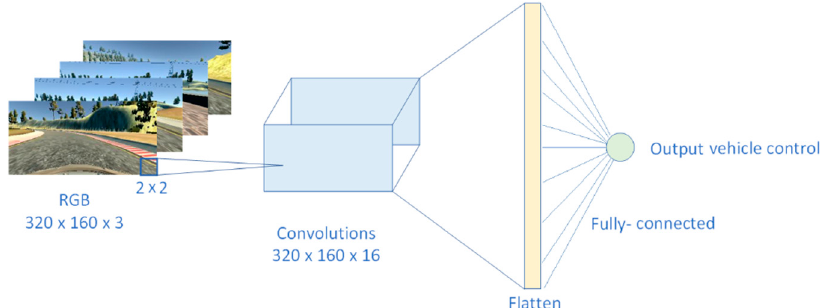
Figure 11. Architecture of experimental shallow deep neural network (DNN) with just one convolutional layer with 32 feature maps, one flattened layer and, at the end, the fully connected layer.